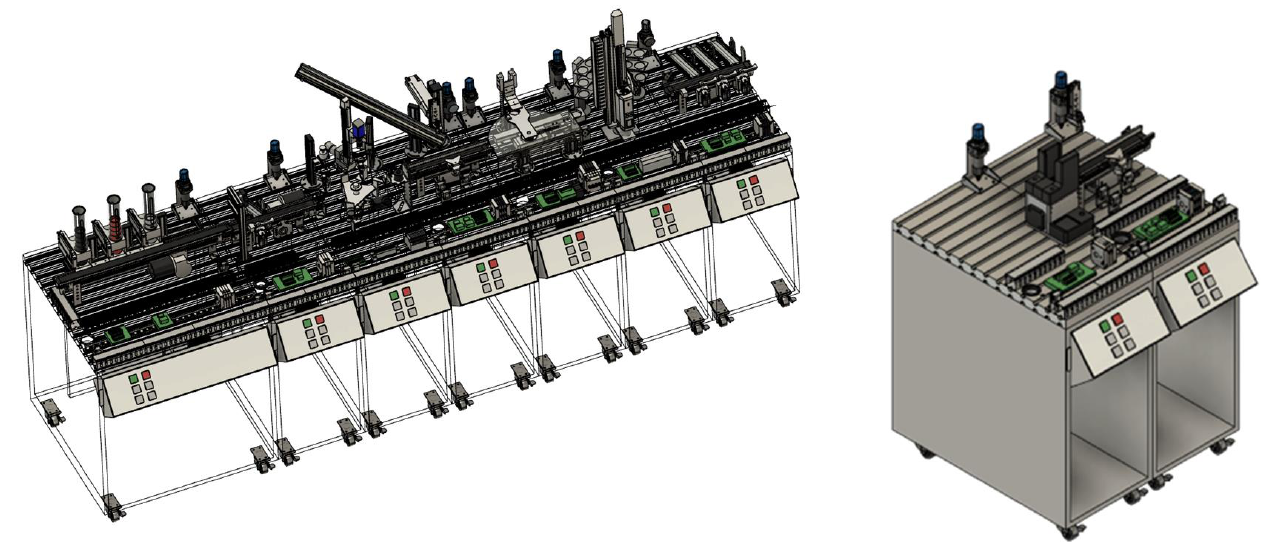
Figure 2. FESTO Didactic line ( left ) and the created testbed ( right ).